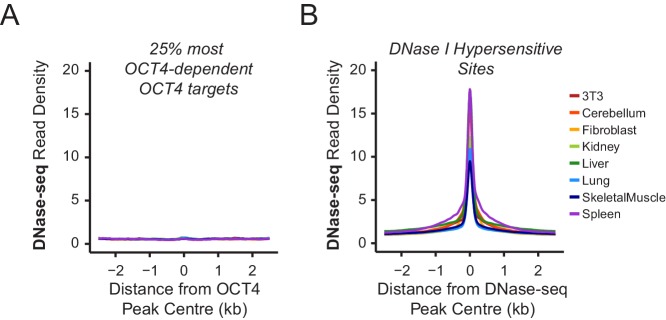
Chromatin accessibility profiling at OCT4 binding sites in somatic cell lines or tissues.(A) A metaplot of ENCODE DNase-seq profiles for eight mouse cell lines or tissues (Yue et al., 2014) at OCT4 targets most dependent upon OCT4 for normal chromatin accessibility (25% most affected in OCT4cond ESCs; as in Figure 1J). This reveals that these sites are completely inaccessible in somatic cell lines or tissues which lack OCT4 expression. (B) A metaplot analysis of ENCODE DNase-seq data in (A) profiled at DNase I hypersensitive sites identified from each cell line/tissue.